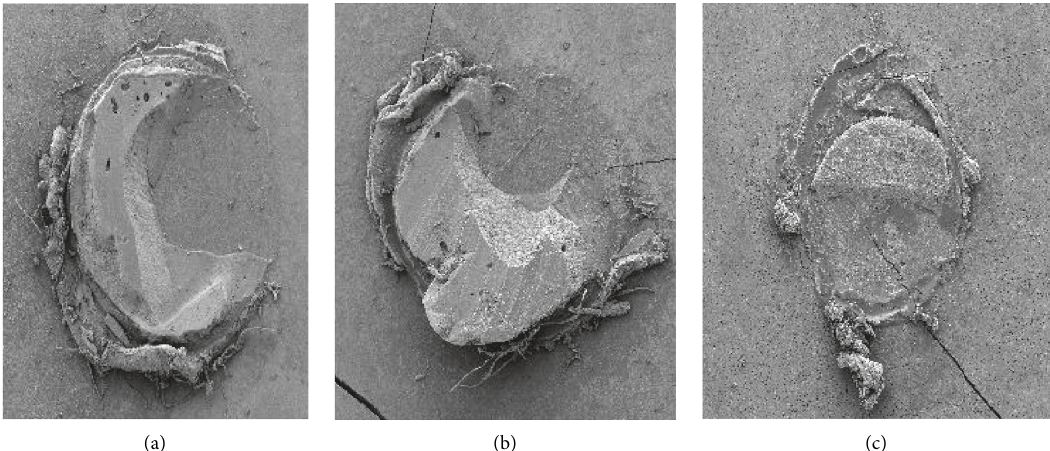
Figure 1: Fracture pattern of the experimental groups observed by SEM (50 × magnification). (a) Mixed fracture in G1; (b) mixed fracture in G2; (c) mixed fracture in